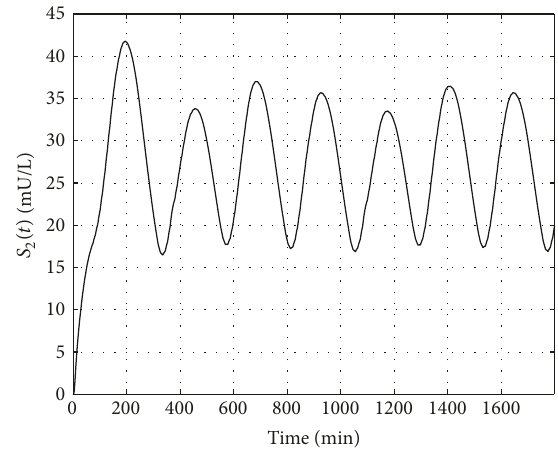
Figure 15: Variation of the second state of the insulin absorption